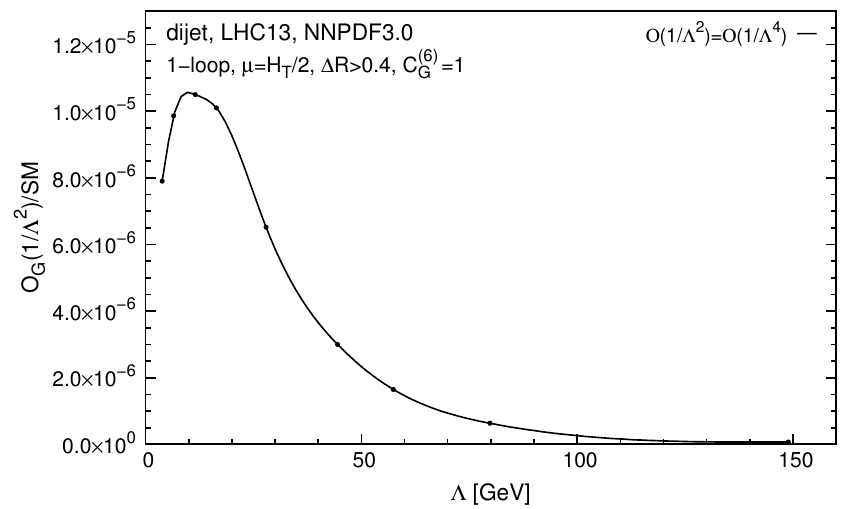
Figure 13 . Contributions from the one-loop interference contribution of order O (1 = (cid:3) 2 ), normalised to the SM yield and in presence of a minimum partonic jet cut p T; min set at the value for which the two contributions of order O (1 = (cid:3) 2 ) and O (1 = (cid:3) 4 ) are equal to each other (see (cid:12)gure